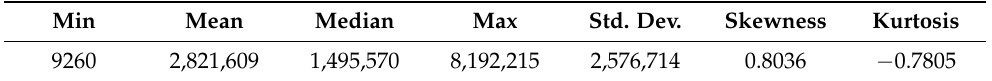
Table 1. Descriptive statistics of international pax air traffic in Greece, January 2017 to July